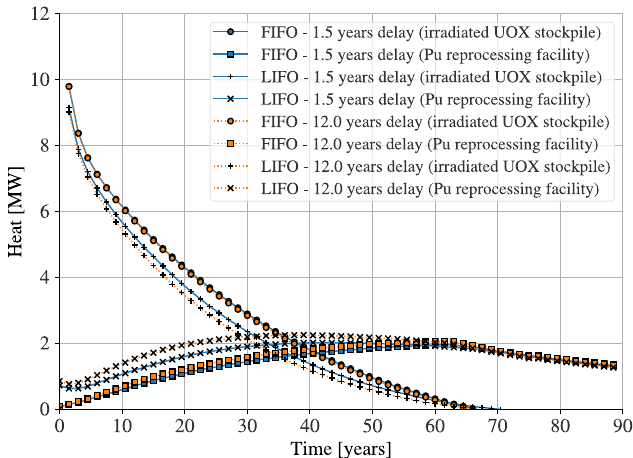
Fig. 10. The time evolution of the heat in the front-end of the fuel cycle scenario (irradiated UOX stockpile and Pu reprocess- ing facility) for every reload cycle as a function of time passed since the reference date t 0 .